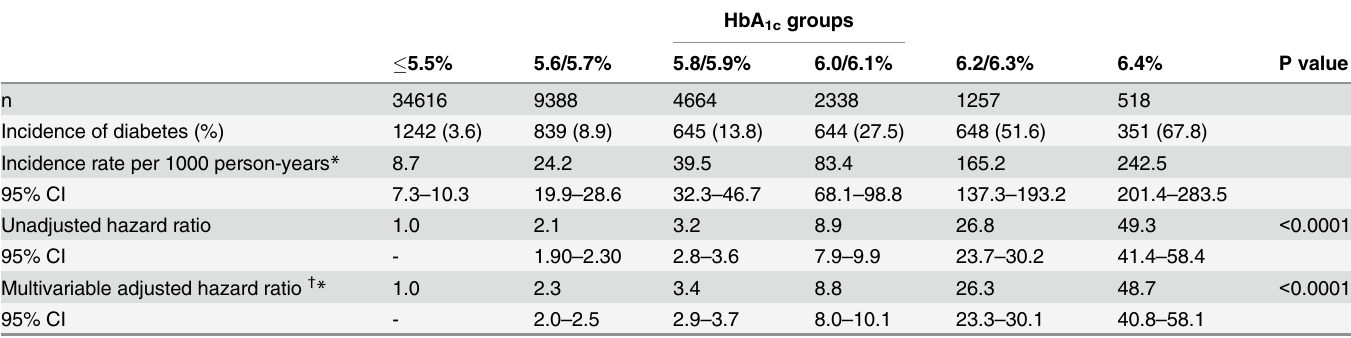
Table 2. The risk of diabetes incidence based on the baseline HbA1c levels in the Cox proportional-hazard model. HbA 1c groups (cid:1) 5.5% 5.6/5.7% 5.8/5.9%